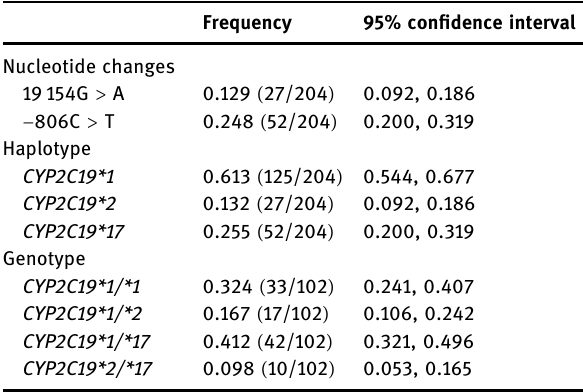
Table 2: Frequency of CYP2C19 nucleotide changes, haplotypes, and